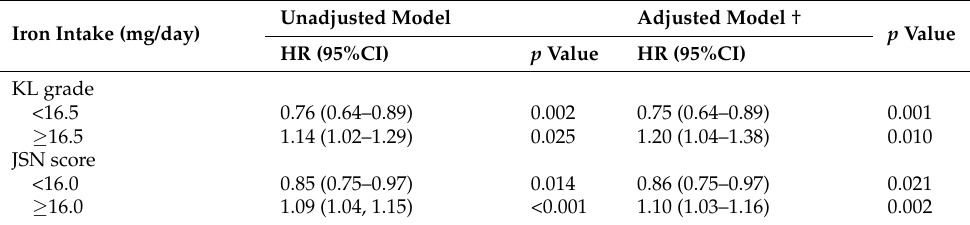
Table 2. Threshold effect analyses of iron intake on the risk of knee OA progression using 2-piecewise regression models.